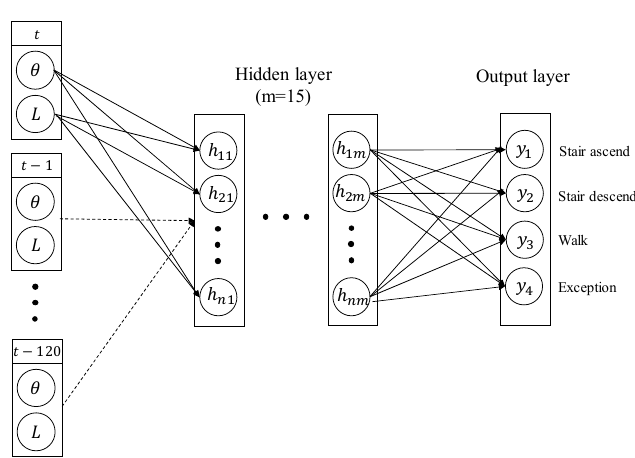
Figure 8. Neural network architecture diagram. The number of input data is 242, and the angle of the motor encoder and the change of LBKA are input. The number of output states is 4, and the number of hidden layers is 15.